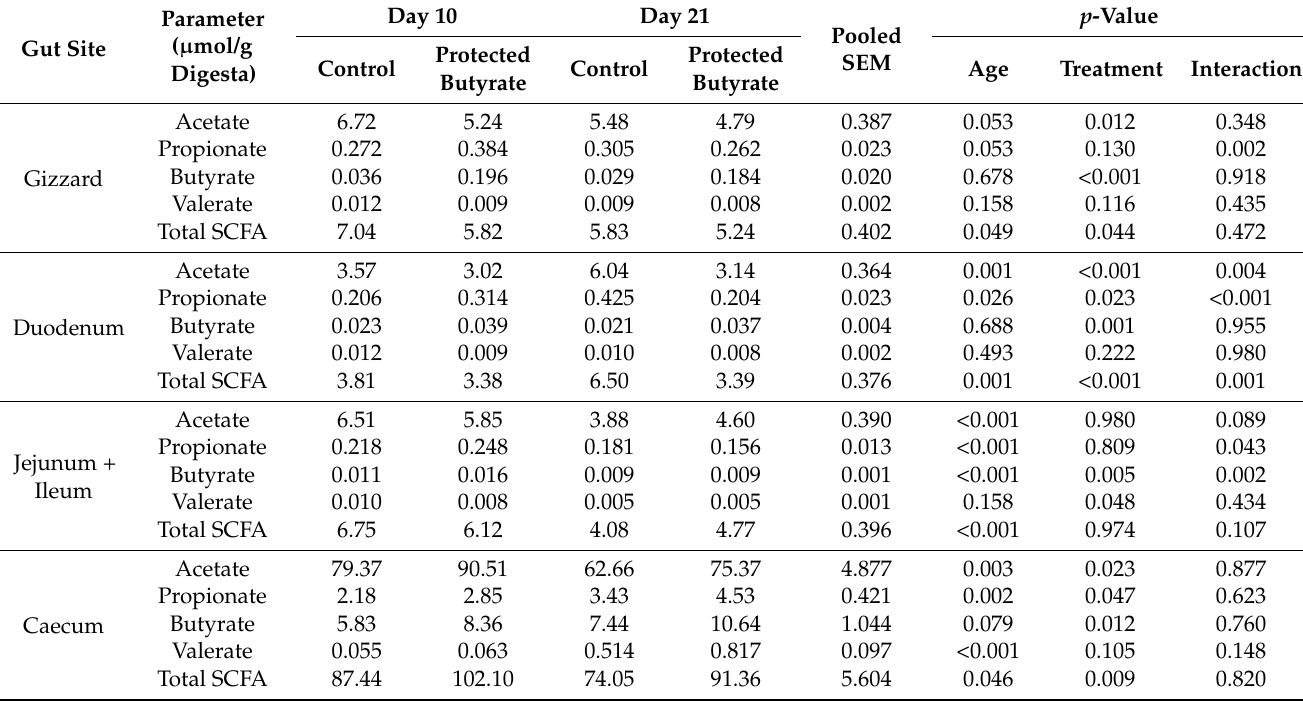
Table 5. Effect of protected butyrate supplementation on individual and total SCFA concentrations in the broiler gut at different days of